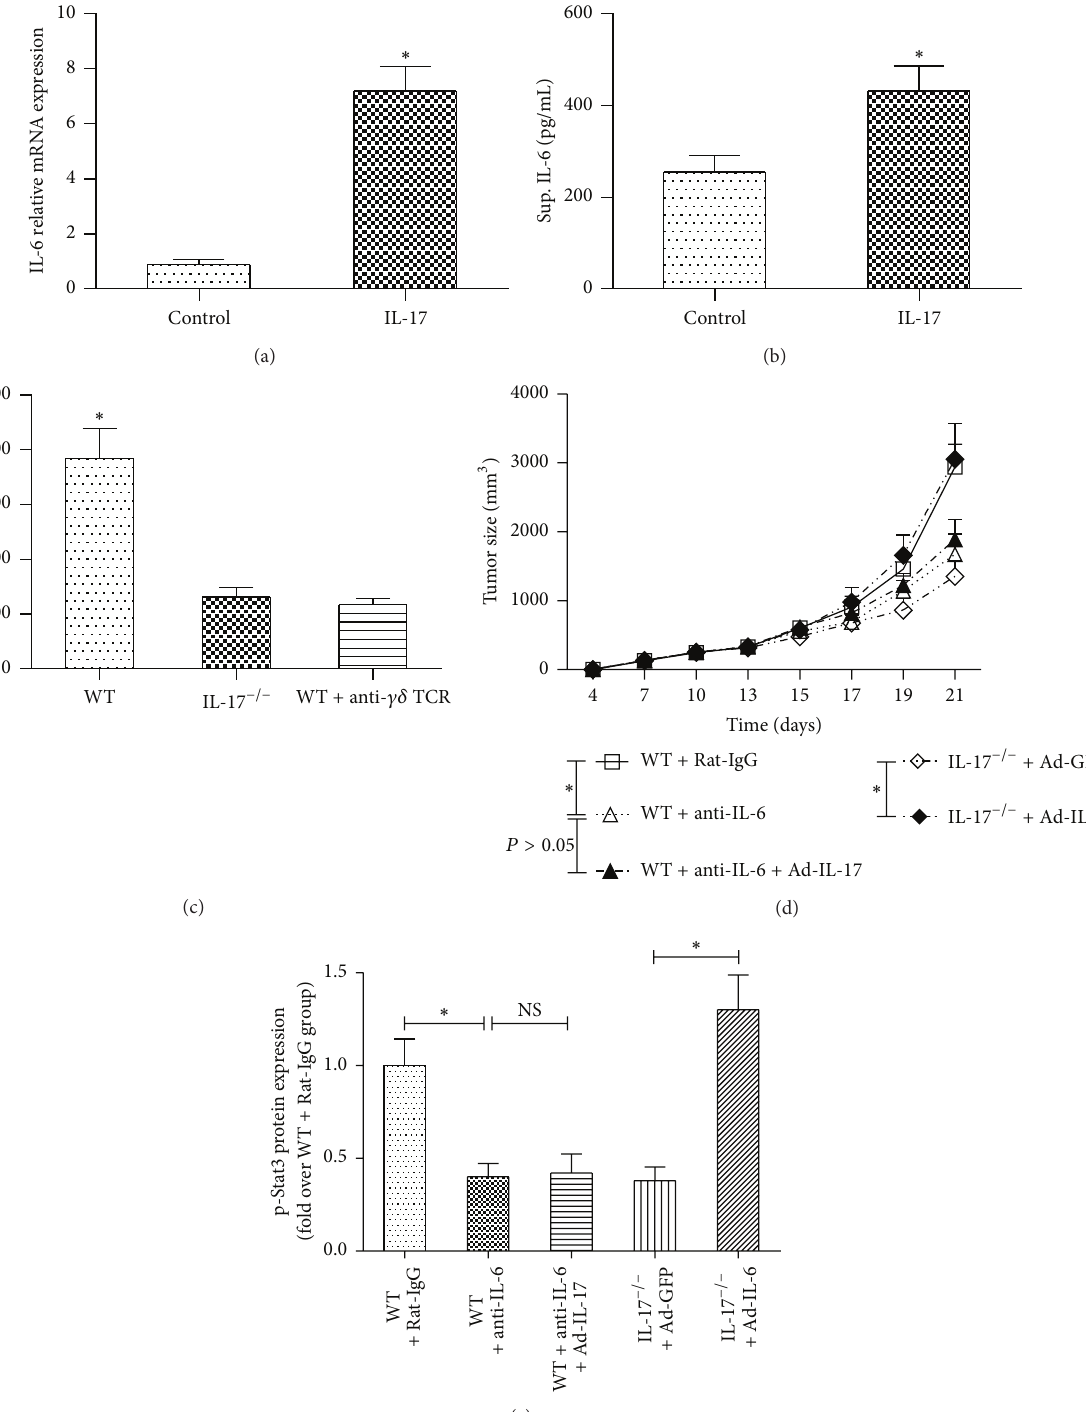
Figure 6: IL-17 activates Stat3 in tumor dependent on IL-6 production. (a) IL-6 level in B16 tumor cells treated for 24 hours with recombinant IL-17 was assessed by quantitative realtime PCR. (b) IL-6 level in B16 tumor cells treated for 24 hours with recombinant IL-17 was assessed by ELISA. (c) Signal-cell suspensions prepared from B16 tumors harvested from WT, WT + anti- 𝛾𝛿 TCR, and IL-17 −/− groups were cultured in vitro overnight; supernatants were then collected and assayed for IL-6 levels ( 𝑛 = 5 ). (d) Tumor growth in B16 tumor cells inoculated mice from WT + Rat-IgG, WT + anti-IL-6, WT + anti-IL-6 + Ad-IL-17, IL-17 −/− + Ad-GFP, and IL-17 −/− + Ad-IL-6 groups ( 𝑛 = 5 ). (e) Indicating p-Stat3 protein levels (analyzed by Western blot) in B16 tumor tissues from WT + Rat-IgG, WT + anti-IL-6, WT + anti-IL-6 + Ad-IL-17, IL-17 −/− + Ad-GFP, and IL-17 −/− + Ad-IL-6 groups. The data show means ± SEM of tumor size and are representative of three independent experiments. ∗ 𝑃 < 0.05 . NS = not